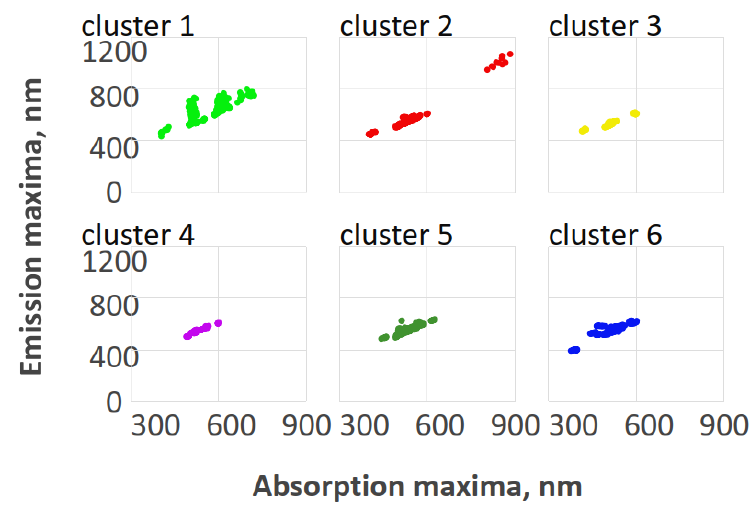
Figure 3. Absorption maxima versus emission maxima plot for a six-cluster dataset of 115 BODIPYs. For a key for the clusters, see in Schemes 1–6.